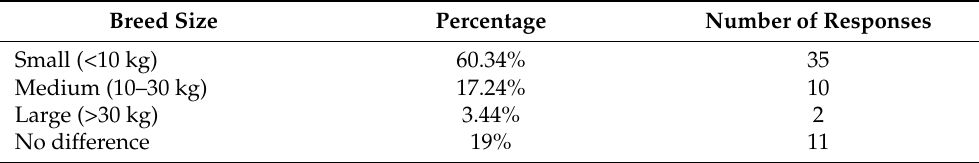
Table 2. Reported predisposition to anal sac disease per breed size in dogs.